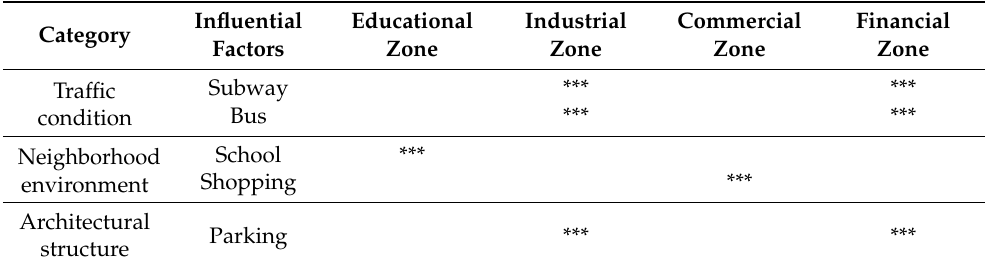
Table 12. Spatial heterogeneity of the influential factors in different functional zones. Influential Educational Industrial Commercial Category Factors Zone Zone Zone